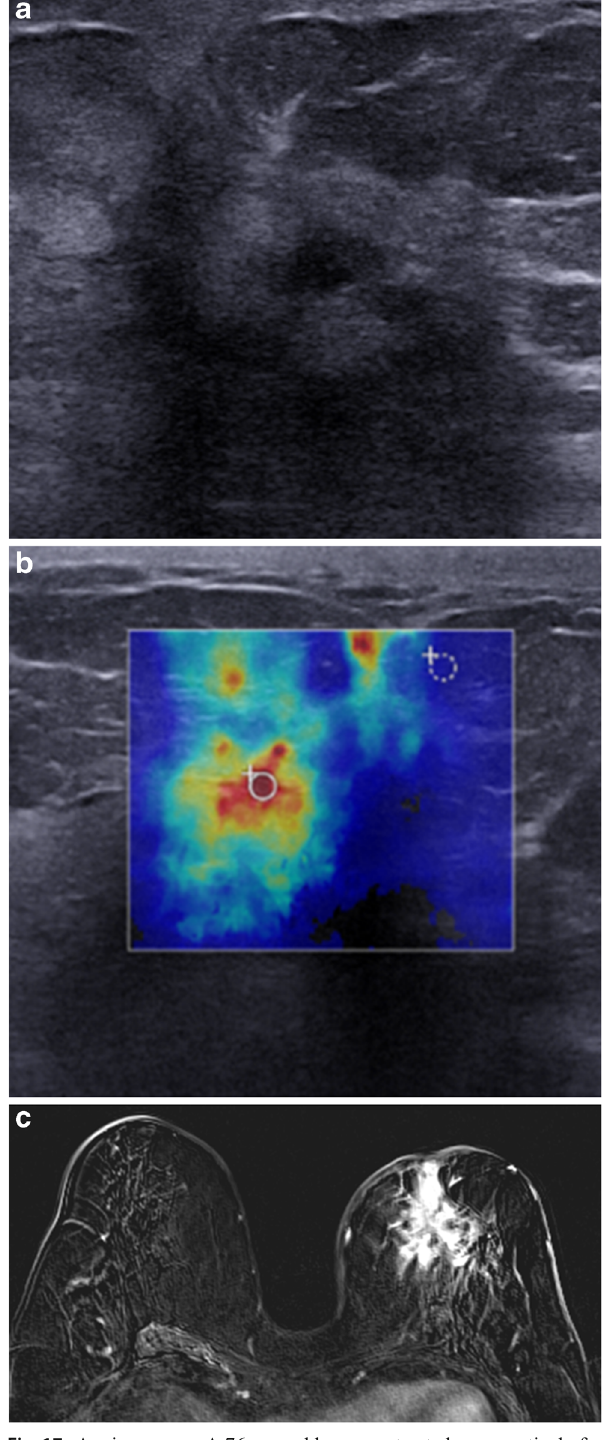
Fig. 17 Angiosarcoma. A 76-year-old woman, treated conservatively for left breast cancer in 1993. Palpation of an upper quadrant breast swelling. a Ultrasound: heterogeneous, hyperechoic mass, with a hypoechoic centre. b Elastography, zones of hardness ( red ) in the periphery of the mass. c MRI, axial gadolinium-enhanced T1 subtraction sequence: spiculated mass with heterogeneous intense contrast enhancement. Histological examination revealed a high-grade moderately to poorly differentiated